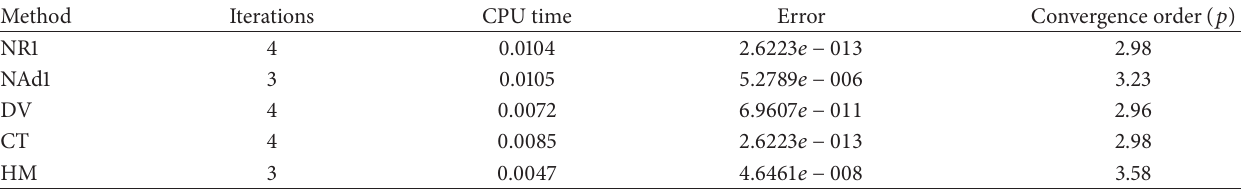
Table 6: Numerical results of Example 5 with initial value 𝑥 0 = (2,2,...,2) 𝑇